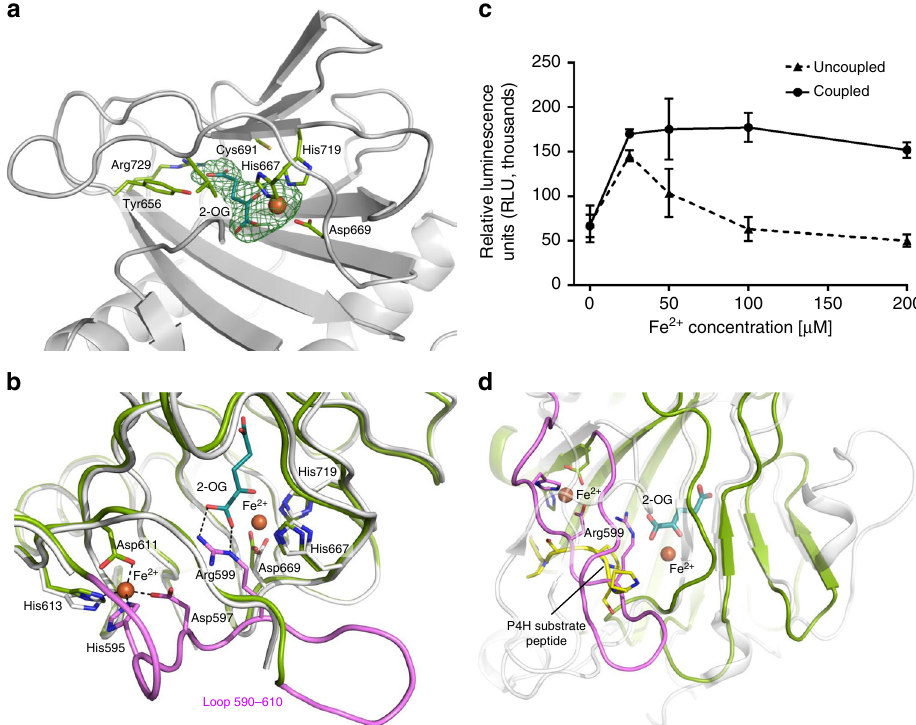
Fig. 3 Insights into LH3 lysyl hydroxylase activity. a All our LH3 structures consistently show clear electron density for bound Fe 2 + and 2-OG in the LH catalytic cavity ( 2F o -F c omit electron density maps, green mesh, contour level 1.2 σ ). Residues involved in interactions with Fe 2 + and 2-OG are shown with green sticks. b Co-crystallizations with Fe 2 + allow identi fi cation of a second metal ion bound near the LH catalytic site that stabilizes the fl exible capping loop 590 – 610 (shown in pink). c Evaluation of collagen substrate coupled and uncoupled LH3 LH activities as a function of Fe 2 + concentration. Error